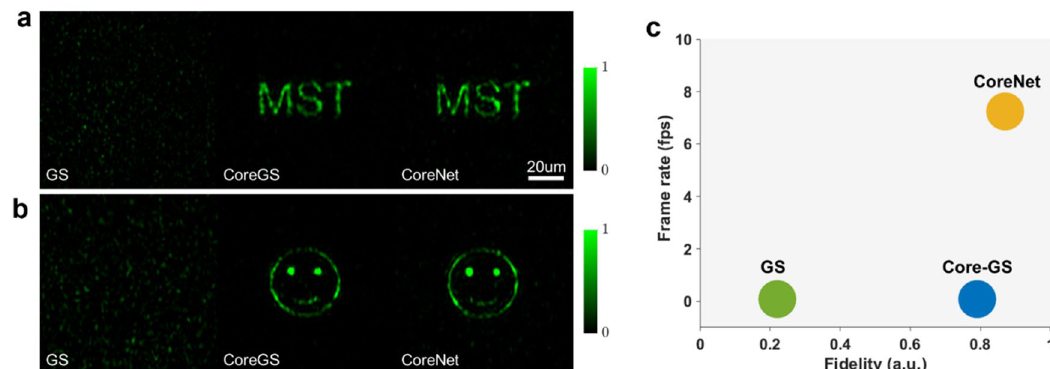
Figure 6. Comparison of GS, Core-GS, and CoreNet. ( a ) Experimental tailored light field generation of letters "MST" at 700 μm away from the distal fiber facet employing the CGHs generated by GS algorithm, Core-GS algorithm, and CoreNet. The scale bar indicates a length of 20 μm. ( b ) Experimental tailored light field generation of a smiling face under the same circumstance. ( c ) Fidelity and computational speed comparison of the three approaches. The fidelity is expressed by the averaged 2-D image correlation coefficients between the reconstructed light field and the target images. The frame rate is the averaged number of generated holograms per second to indicate the computational speed of the algorithm.